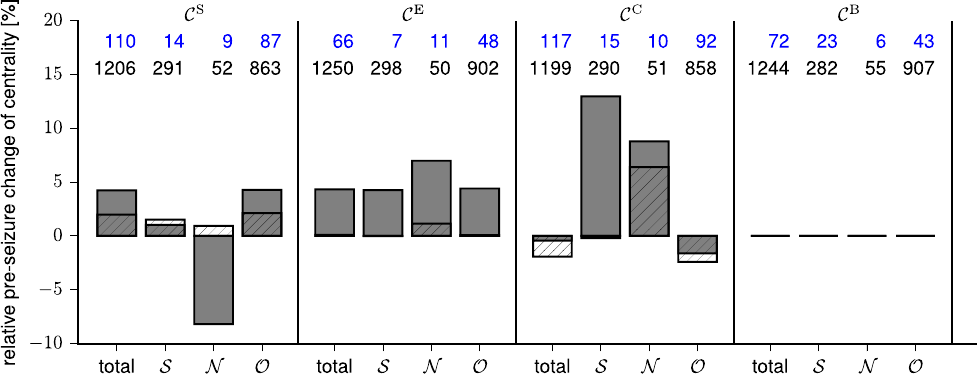
Figure 1. Relative pre-seizure change of centrality values of nodes in the different modules. Non-hatched/ hatched bars represent median values over predictive/non-predictive nodes (median pre-seizure centrality values referenced against median centrality values from seizure-free periods). Blue/black numbers on S B top represent the number of predictive/non-predictive nodes in each module ( C strength centrality; C C E betweenness centrality; C closeness centrality; C eigenvector centrality; “total” refers to the sum of these nodes). As betweenness centrality often yields values of 0, calculating a relative difference is not always possible, therefore we refer to the median absolute value which here amounts to 0.005 independent of the module (SOZ: S , neighbours: N , others: O